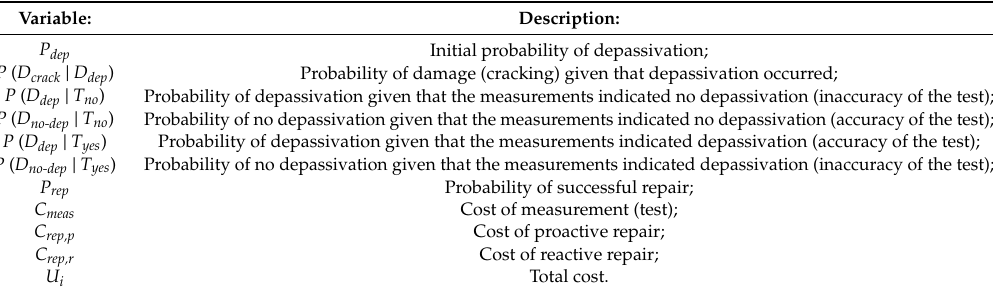
Table 1. Variables and probabilities used for the analysis.